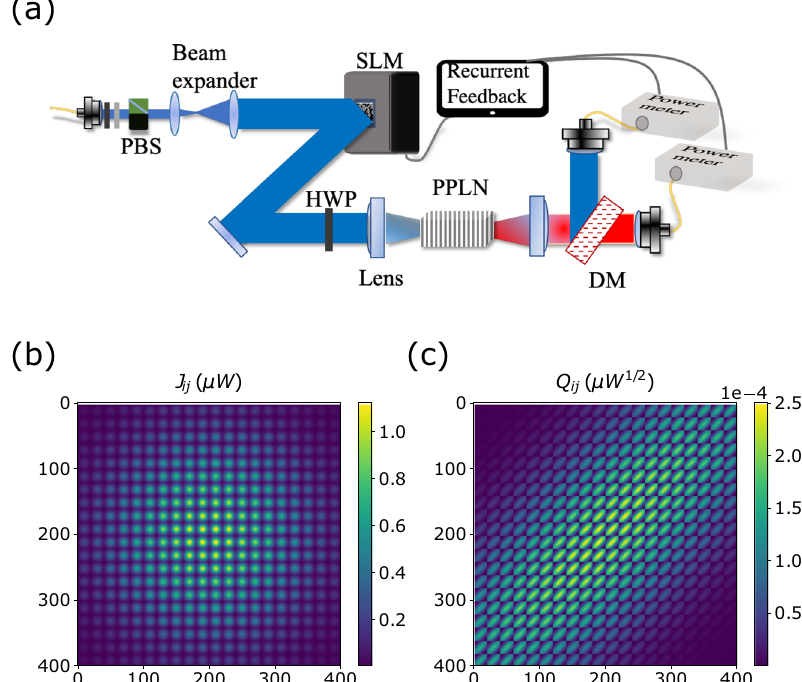
Fig. 1 Realization of a nonlinear optical Ising machine with two-body and four-body spin interactions. a Sketch of the experimental setup for the nonlinear optical Ising machine. The linearly polarized pump light (blue) incidents on a SLM, and then it is focused into a nonlinear crystal. The generated SH (red) and residual pump lights are coupled into separate single mode fi bers and measured by the power meters. PBS: Polarizing Beam Splitter, HWP: Half Wave Plate, SLM: Spatial Light Modulator, PPLN: Periodically Poled Lithium Niobate, DM: Dichroic Mirror. b The two-body and ( c ) the reduced four- body spin interaction matrices J ij and Q ij for a 20 × 20 spin